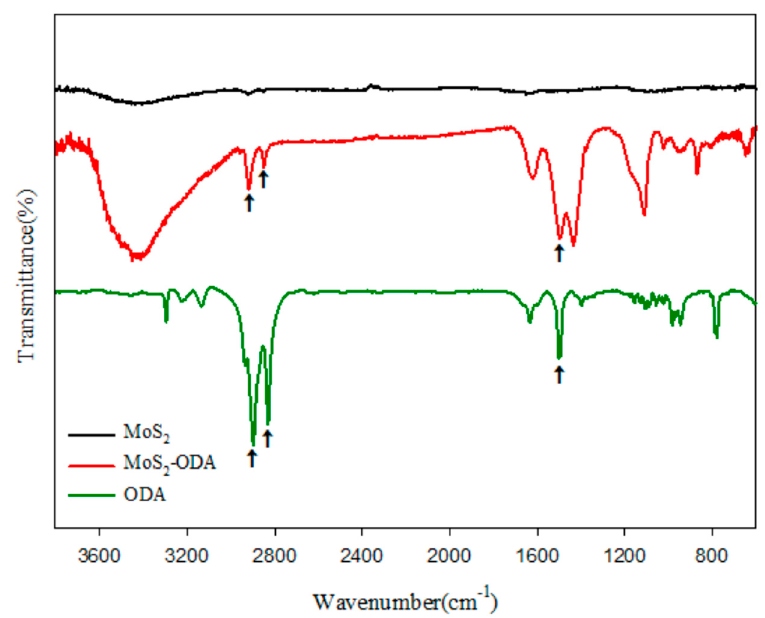
Figure 1. Fourier-transform infrared spectroscopy (FT-IR) spectra of MoS 2 , MoS 2 -ODA and octadecylamine (ODA).